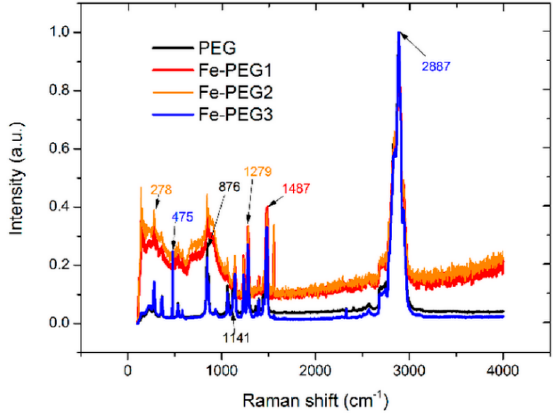
Figure 5. Raman spectra of pure PEG (black line) and the Fe-PEG composites (Fe-PEG1—red line, Fe-PEG2—orange line, Fe-PEG3—blue line).